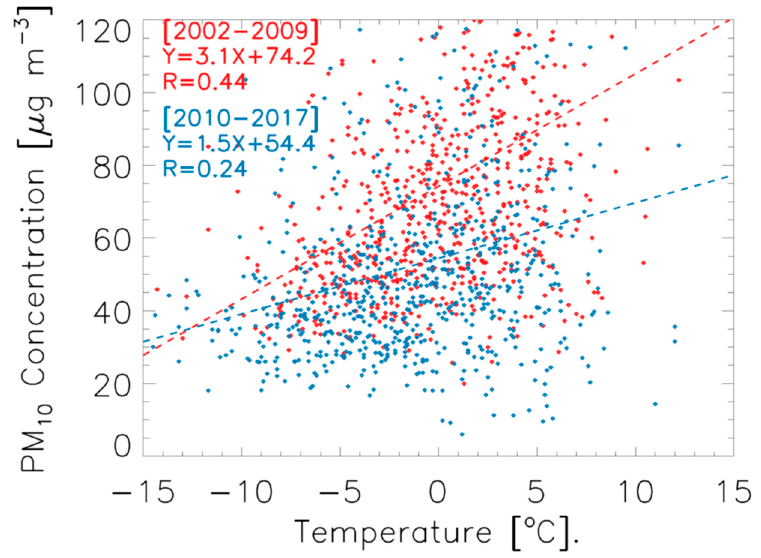
Figure 4. Scatterplot of the daily averaged surface PM 10 versus the daily averaged surface temperature over Seoul. The red and blue diamonds indicate the data for 2002–2009 and 2010–2017, respectively. The red and blue dashed lines show the regression between the PM 10 and temperature in 2002–2009 and 2010–2017, respectively. Units of PM 10 concentration and temperature are μ g m − 3 and ° C, respectively.